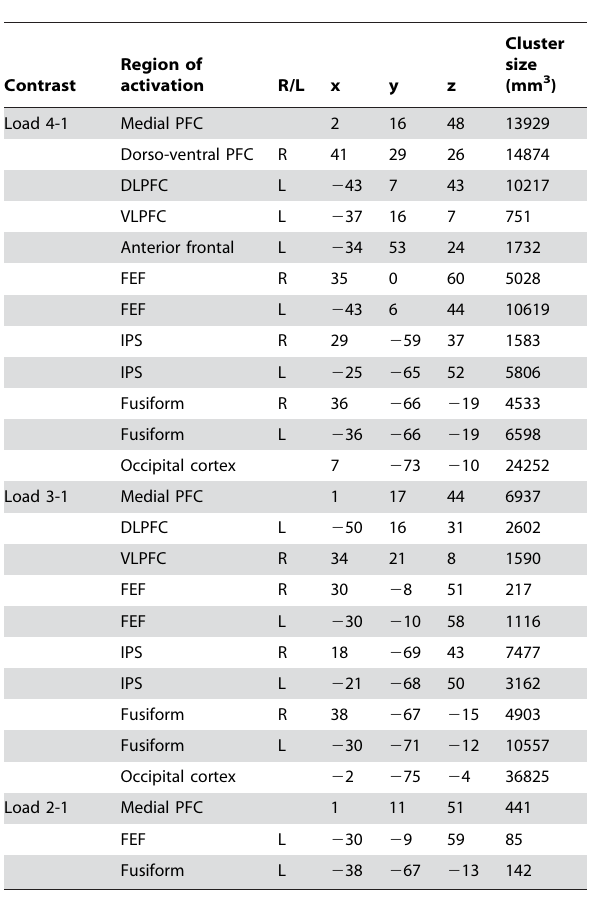
Table 3. Talairach coordinates and voxel cluster size values for face loads 4 minus 1, 3 minus 1, and 2 minus 1 contrasts (FDR , .05).